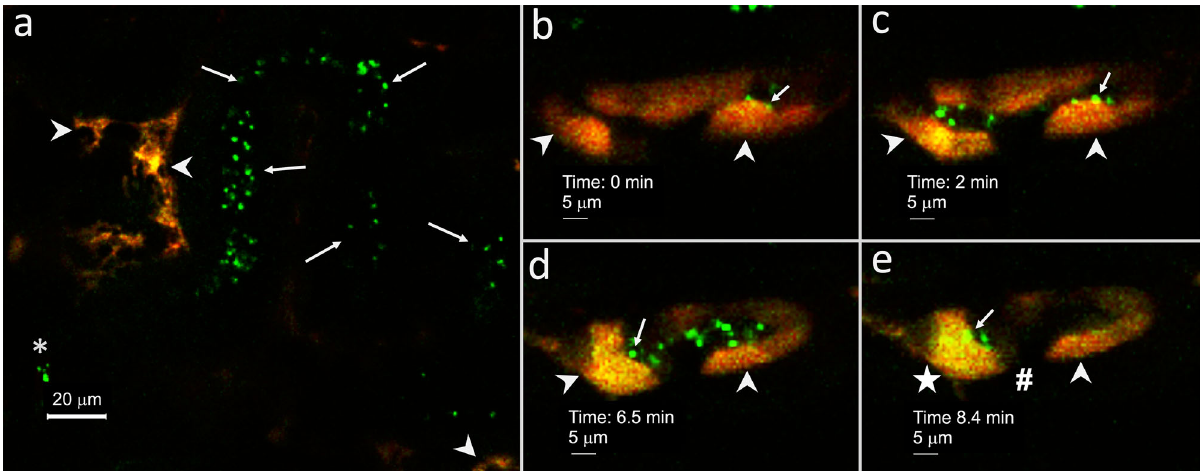
Fig. 7 Intravital confocal microscopy demonstrates murine IC phagocytosis of UPEC in real time. A single renal connecting and/or collecting tubule of a “ IC reporter ” mouse was perfused with GFP expressing UPEC and imaged during confocal intravital microscopy. a An example of the imaging with tdT expressing ICs (red) (arrows), the needle tip (asterisk) and GFP expressing UPEC (green) (arrows) fl owing through a tubular lumen are presented. Approximately, 1 min after the UPEC injection into the tubule, target tdT + ICs were identi fi ed and imaging was started with the 0 ( b ), 2 ( c ), 6.5 ( d ), and 8.4 ICs have luminal UPEC aggregates (arrow) and punctate areas of yellow (arrowheads) consistent with internalization of the green UPEC into the red ICs. expression (pound sign) (presumed principal cells) have little-to-no green UPEC uptake. UPEC aggregates remain around the luminal IC surface